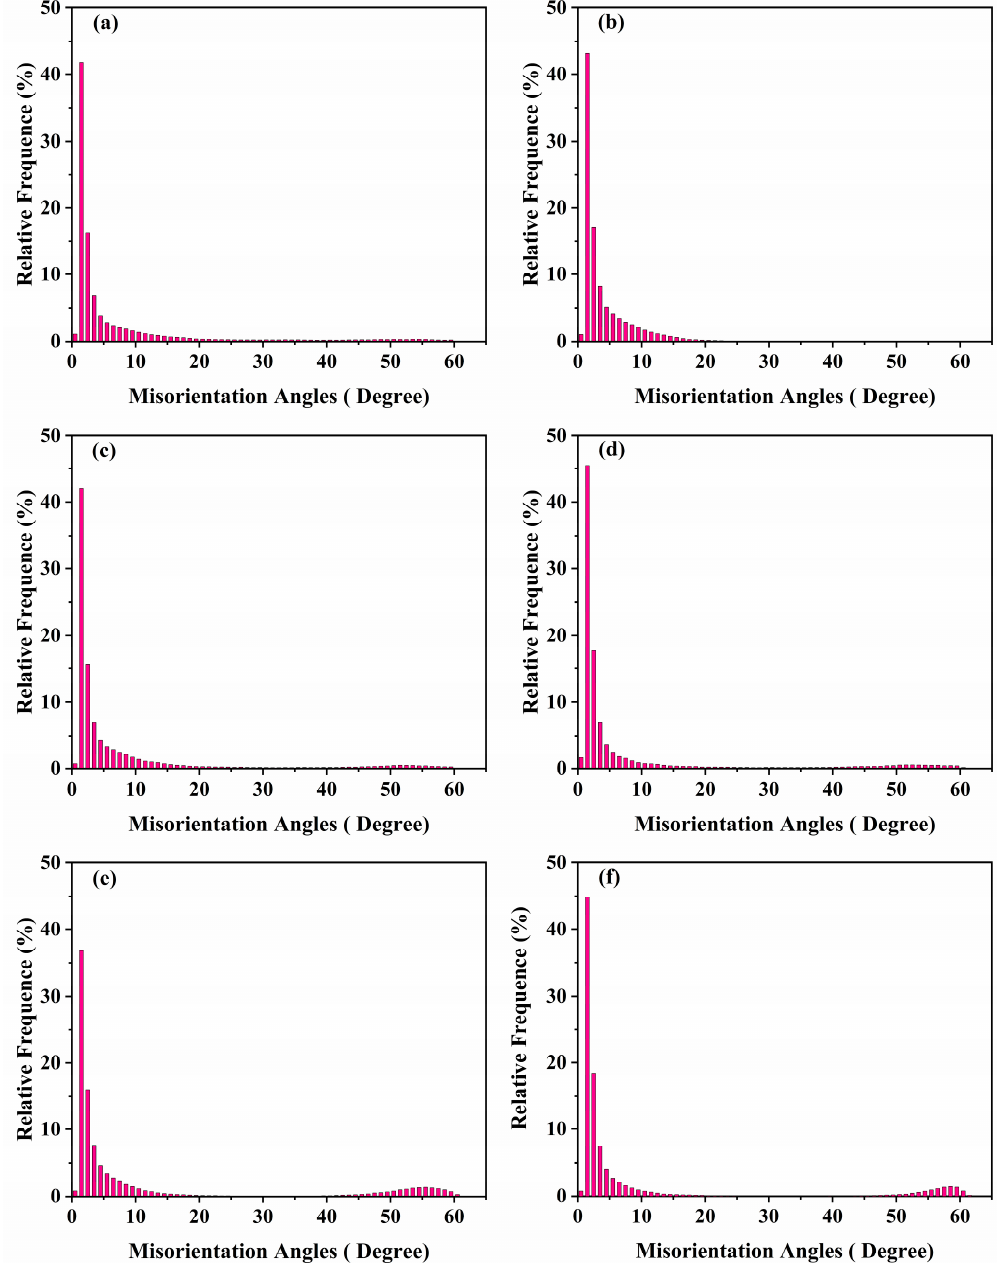
Figure 2. Misorientation angles distributions for the cold rolled alloys: ( a ) Al-3Mg-0.5Mn; ( b ) Al-3Mg-0.5Mn-0.2Er; ( c ) Al-3Mg-0.5Mn-0.2Zr; ( d ) Al-3Mg-0.5Mn-0.2Cu; ( e ) Al-3Mg-0.5Mn-0.2Si; ( f ) Al-3Mg-0.5Mn-0.2Zn.